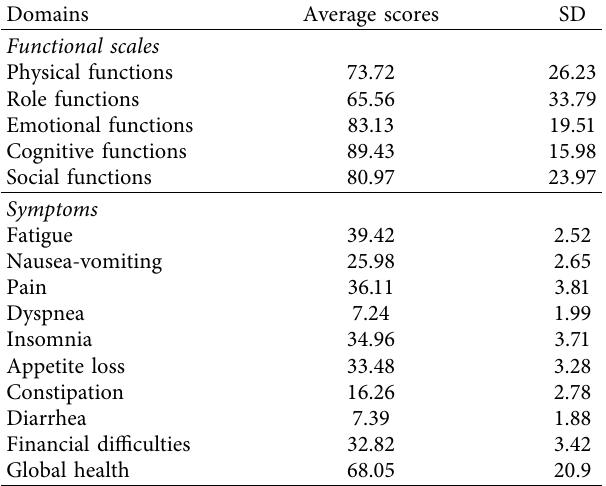
Table 4: Domains of the European Organization for Research and Treatment for Cancer (EORTC